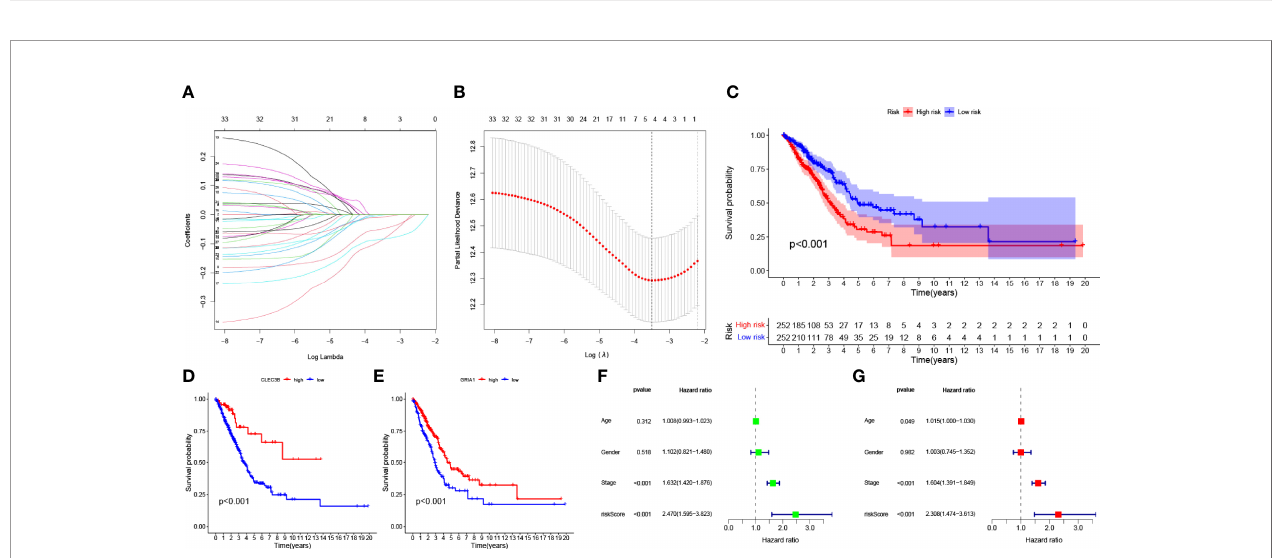
FIGURE 3 | (A) Variation curve of the regression coef fi cient with Log ( l ) in Lasso regression. (B) Ten-fold cross-validation for tuning parameter selection in lasso regression. Vertical lines are drawn from the best data according to the minimum criterion and 1 standard error criterion. (C) Kaplan – Meier curve analysis showing the difference in overall survival between high-risk and low-risk groups in TCGA-LUAD cohort. Kaplan – Meier curve analysis showed the difference in overall survival of the CLEC3B (D) gene and GRIA1 (E) gene between the high expression group and low expression group. (F) Univariate Cox regression results for overall survival. (G) Multivariate Cox regression results for overall survival.